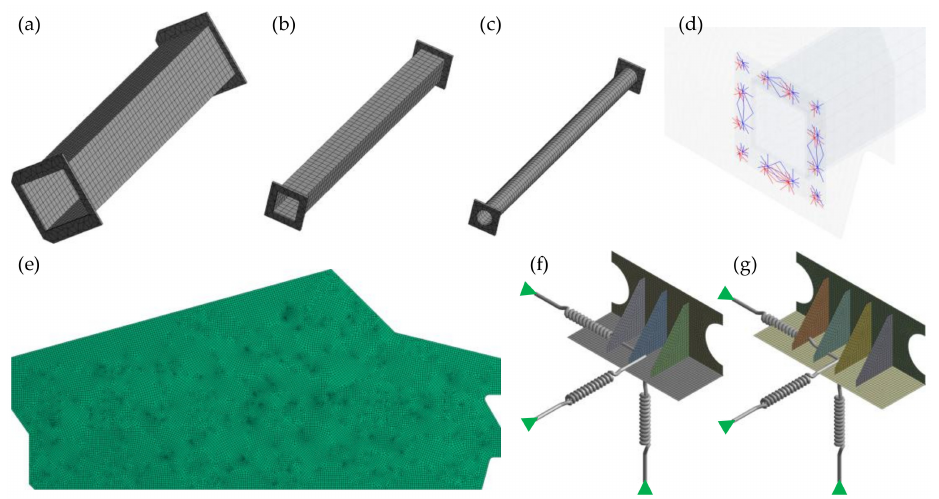
Figure 2. Meshed finite element model of the mining vibrating screen structures: ( a ) meshed exciting beam, ( b ) meshed bearing beam, ( c ) meshed reinforcing beam, ( d ) bolted connection, ( e ) meshed lateral plate, ( f ) loading side spring seat with simplified springs, and ( g ) unloading side spring seat with simplified springs.